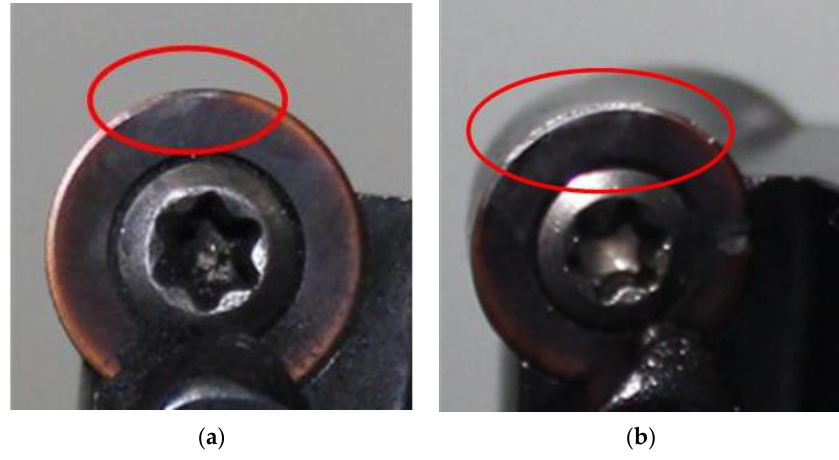
Figure 4. Samples of different tool states, ( a ) mild wear tool; ( b ) severe wear tool.